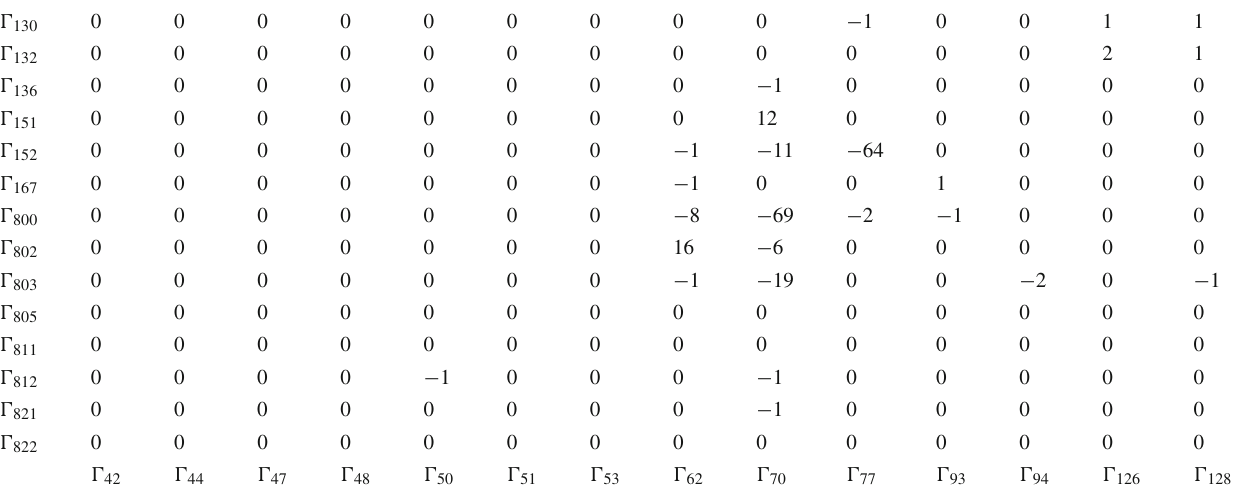
Table 310 Basis quantities correlation coefficients in percent, subtable 6